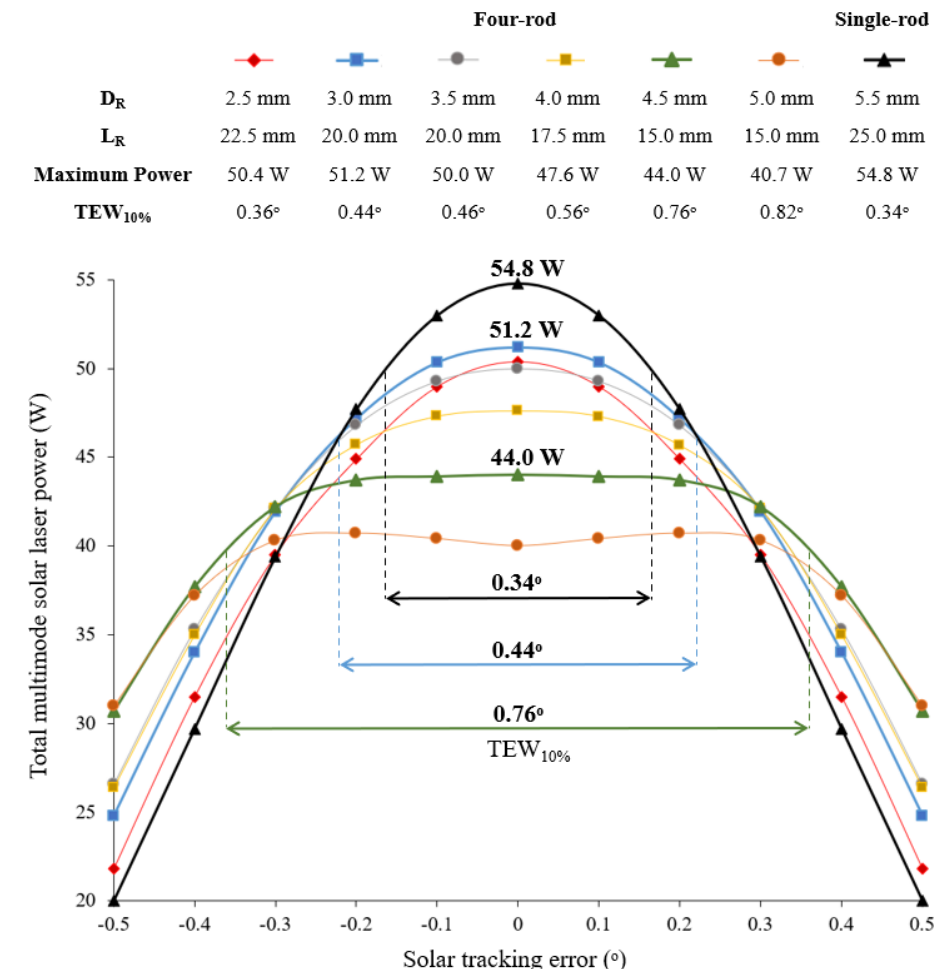
Figure 6. Total multimode solar laser power for the four-rod scheme as a function of the solar tracking error, ranging from the optimal alignment (0.0°) to 0.5° for different rod diameters. A single-rod scheme with D R = 5.5 mm and L R = 25.0 mm is also presented for comparison.